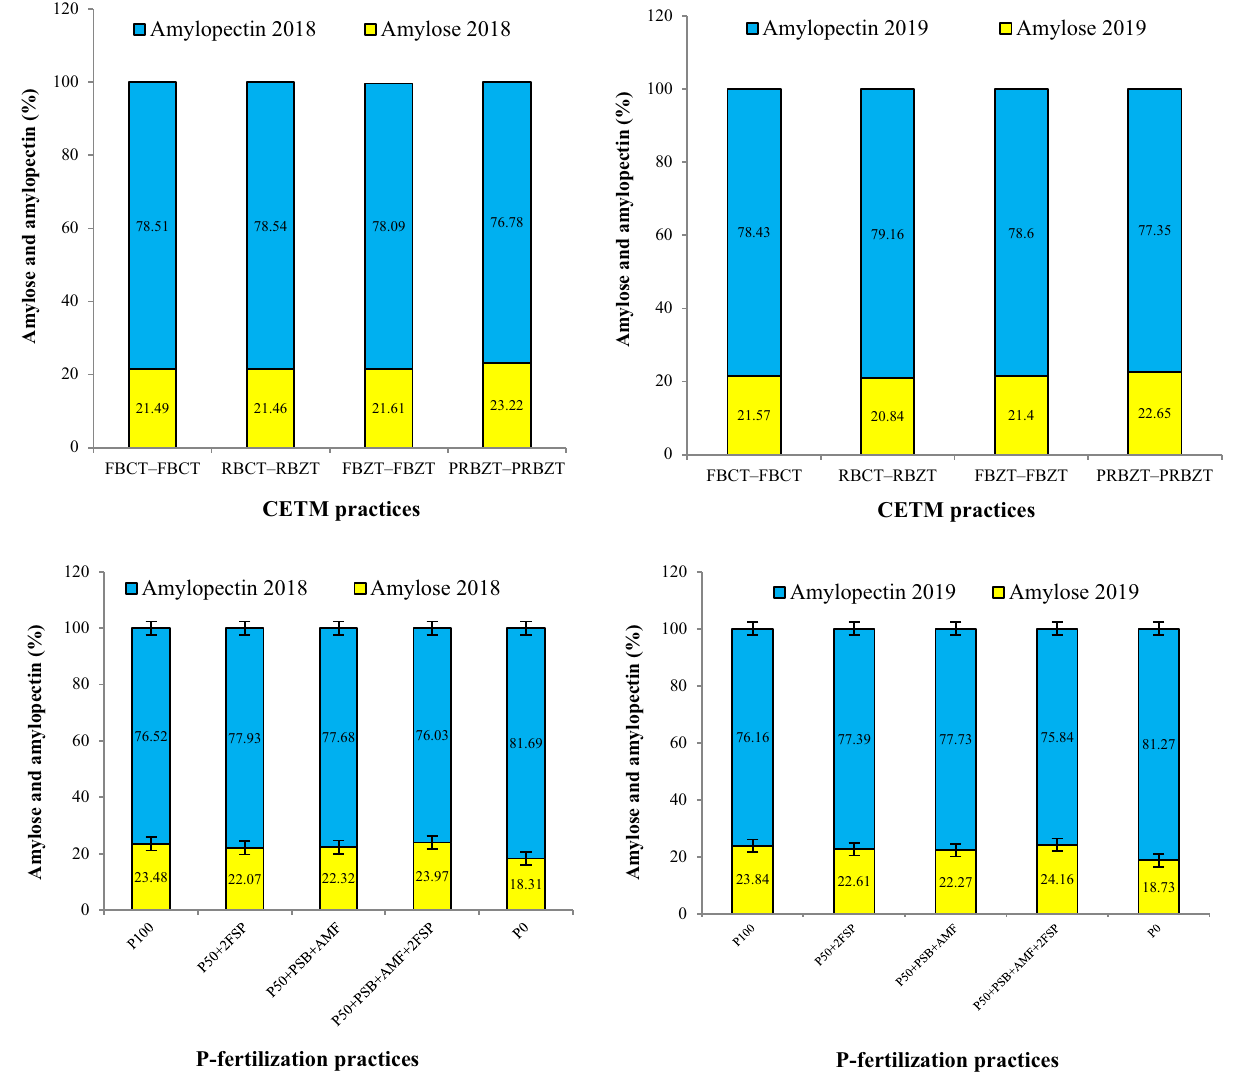
Figure 2. Influence of CETM and P-fertilization practices on grain amylose and amylopectin content of maize under MWCS. The vertical bars represent LSD 0.05